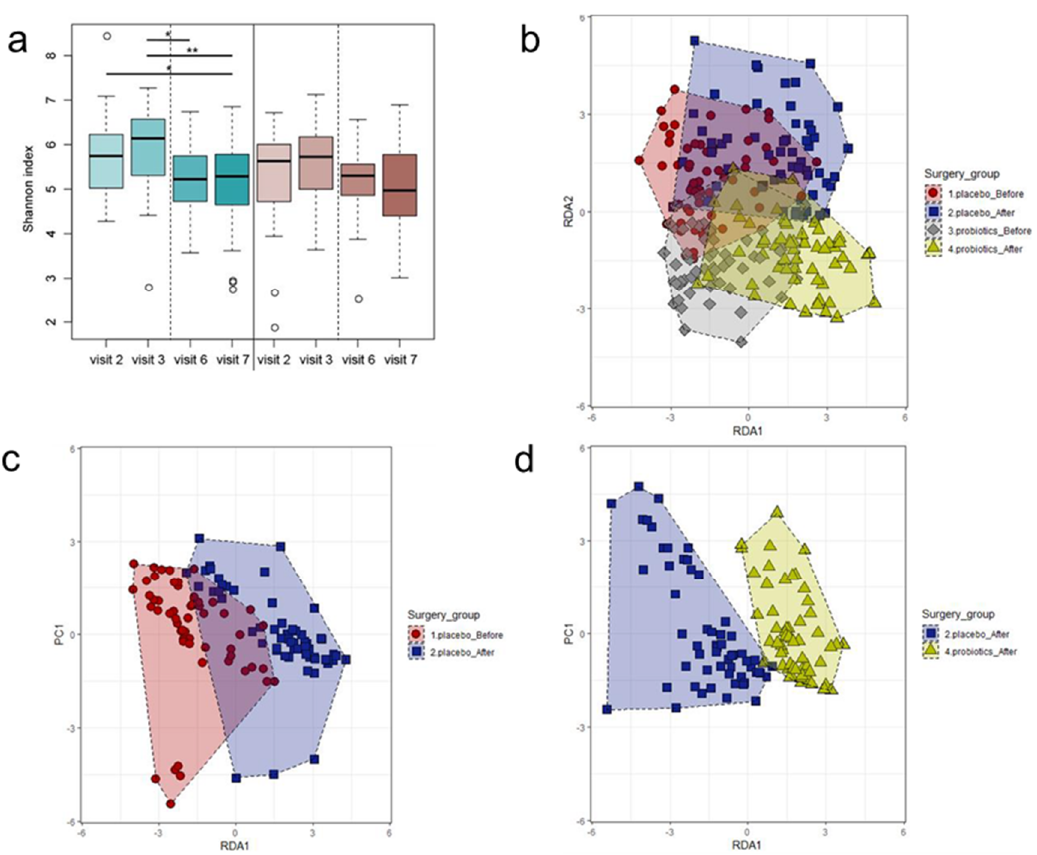
Figure 3. Diversity analysis at each time point. ( a ) α -Diversity analysis between each visit’s fecal sample for both groups. ( b ) β -Diversity of the placebo and probiotics group categorized as before and after surgery. ( c ) β -Diversity of the placebo group before and after surgery. ( d ) β -Diversity before and after surgery between the placebo and probiotics groups. RDA, redundancy analysis.